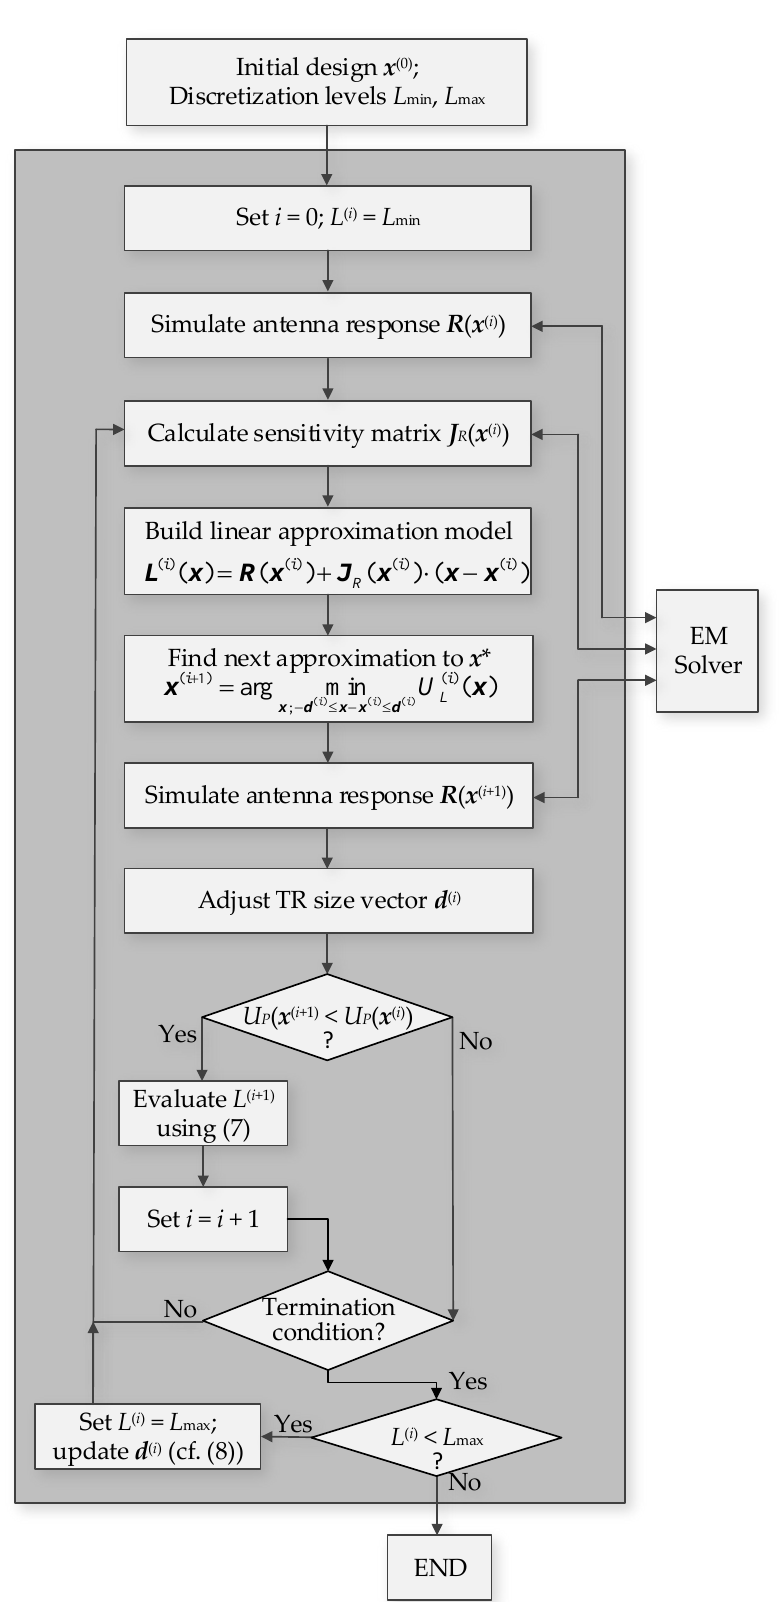
Figure 4. EM- driven size-reduction using multi-fidelity simulations: flow diagram.